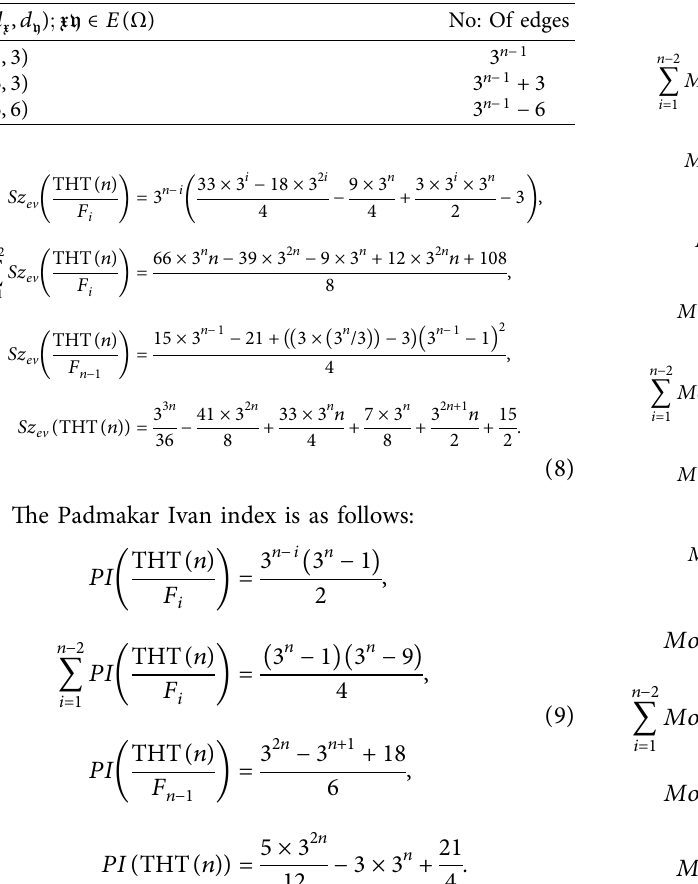
Table 3: Partition of edges of ternary hypertree of dimension n grounded on the degree vertices.